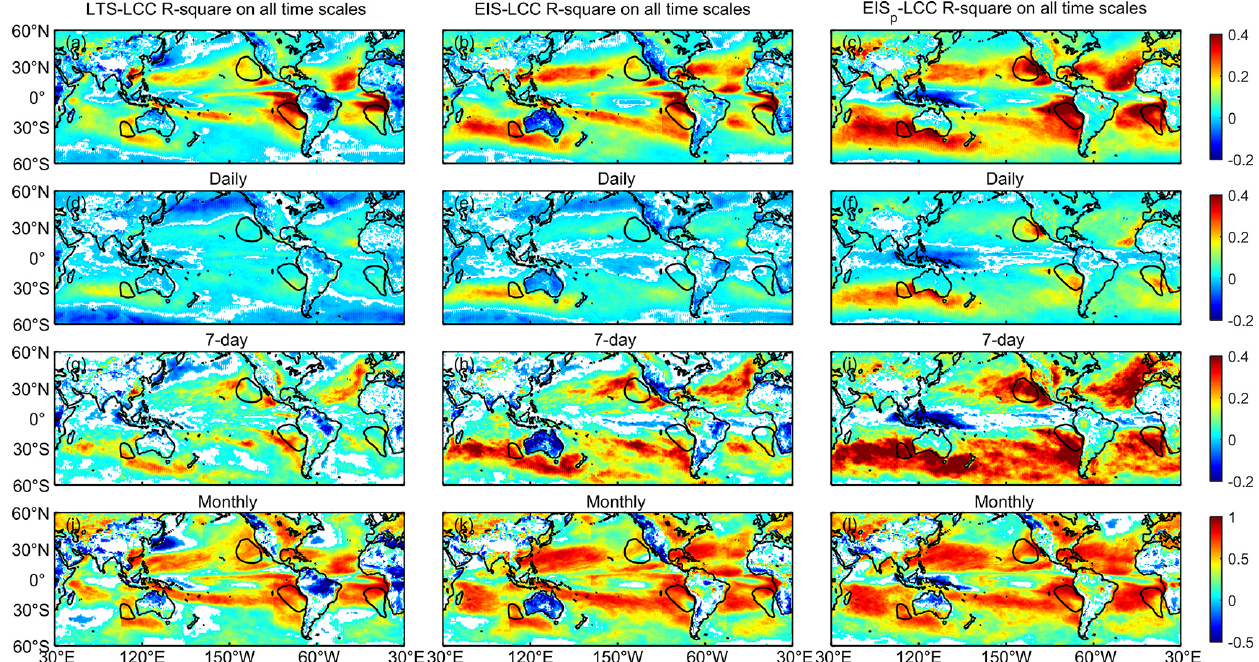
Figure 9. R square between the GEO-MODIS LCC and the ERA5 reanalysis-based LTS (left column), EIS (middle column) and EIS p (right column) at the all timescales (a–c) , daily timescale (d–f) , 7d timescale (g–i) and monthly time scale (j–l) . The black contours enclose regions with LCC larger than 60%. Only R squares at the 95% significance level are shown. The minus (plus) sign of R square indicates negative (positive)